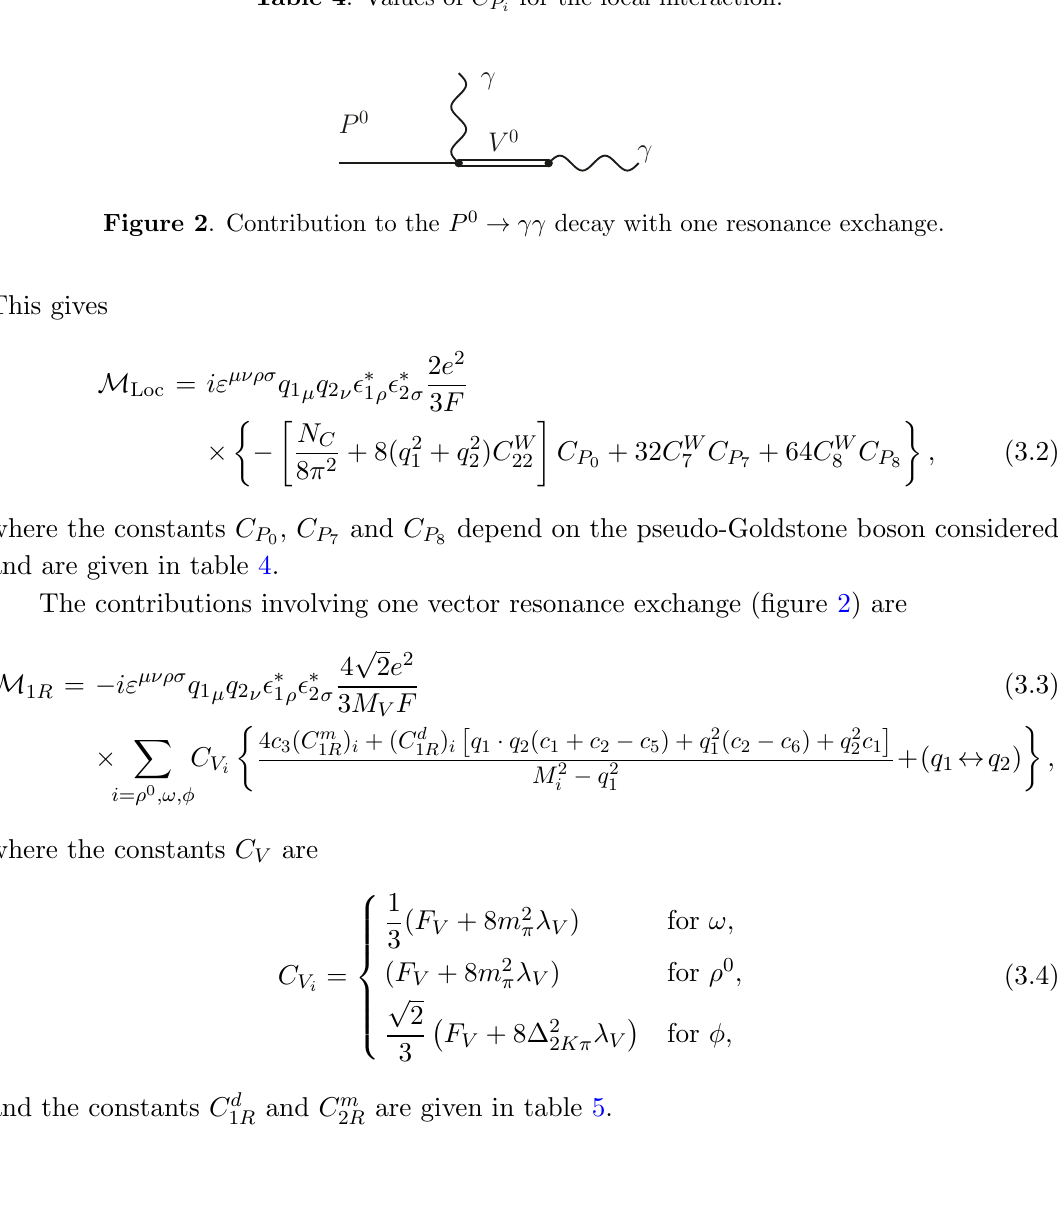
Table 4 . Values of C P